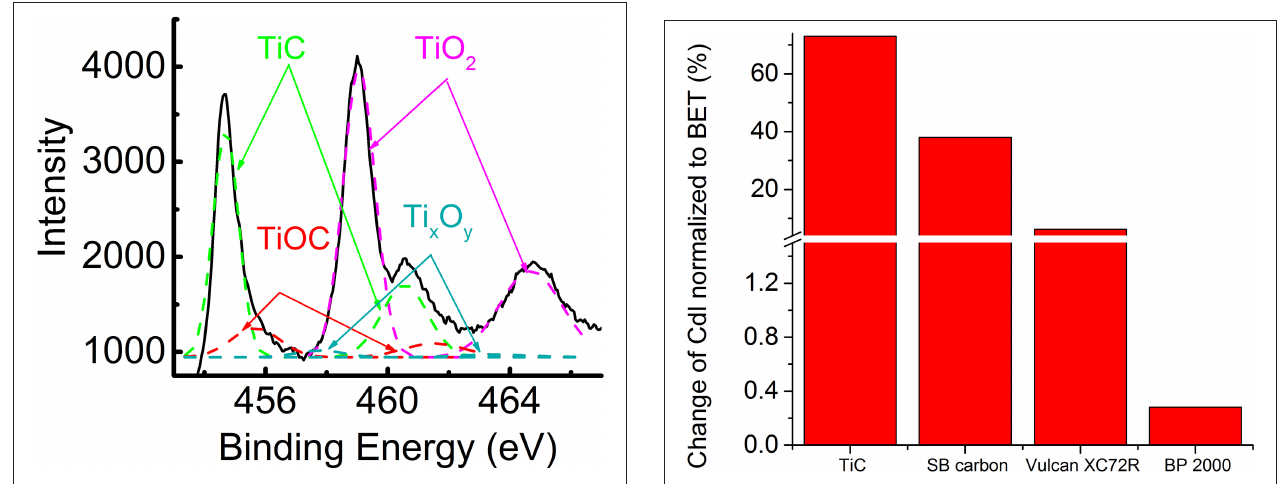
FIGURE 11 | High resolution XPS spectrum of TiC surface recorded in the Ti2p binding energy region.